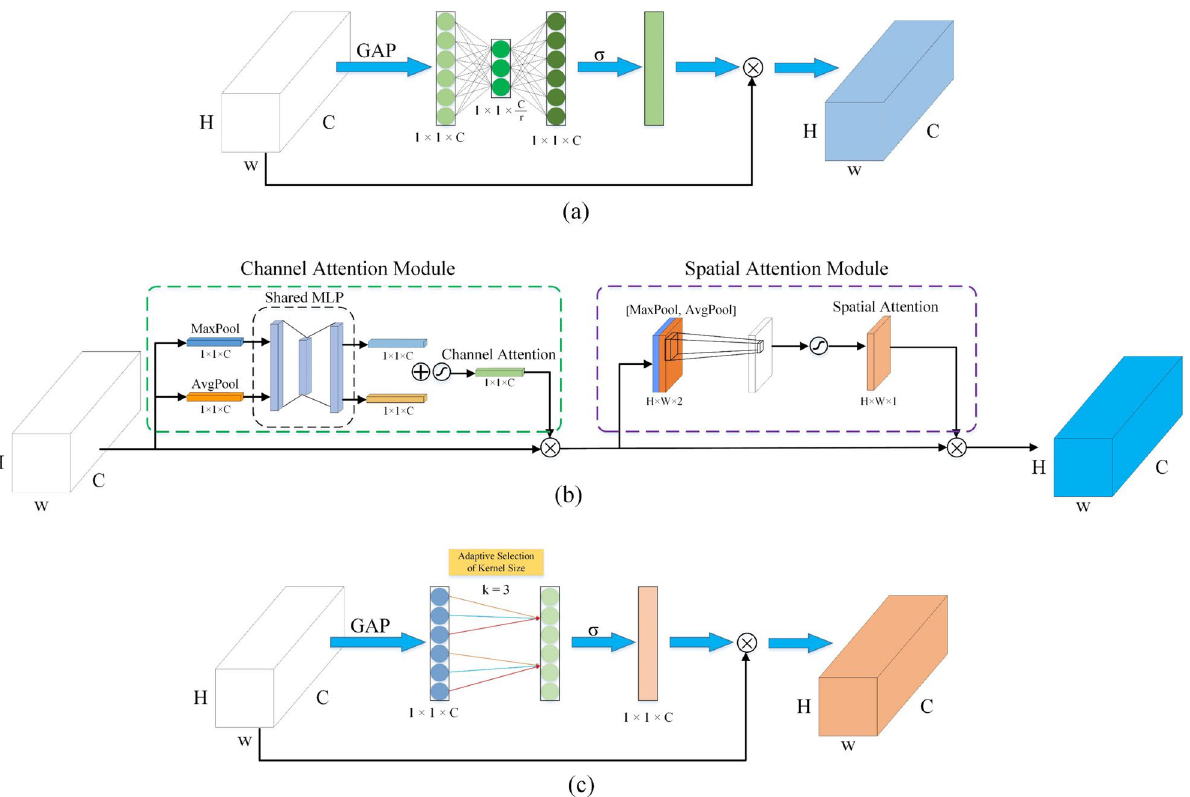
Figure 6. ( a ) SE block, ( b ) CBAM block, ( c ) ECA block. W , H , and C are width, height, and channel dimension (i.e., number of